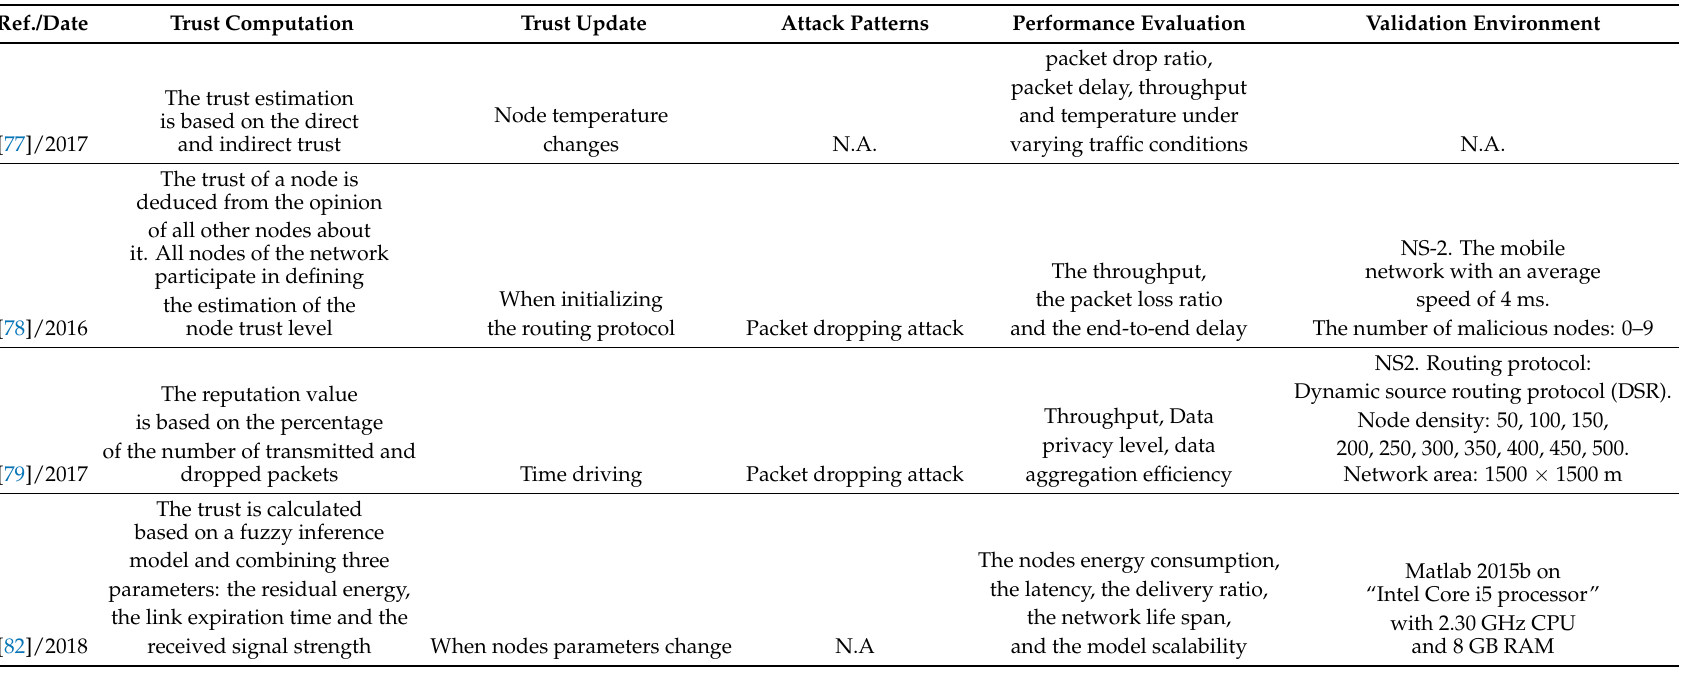
Table 5. Surveys related to the security in